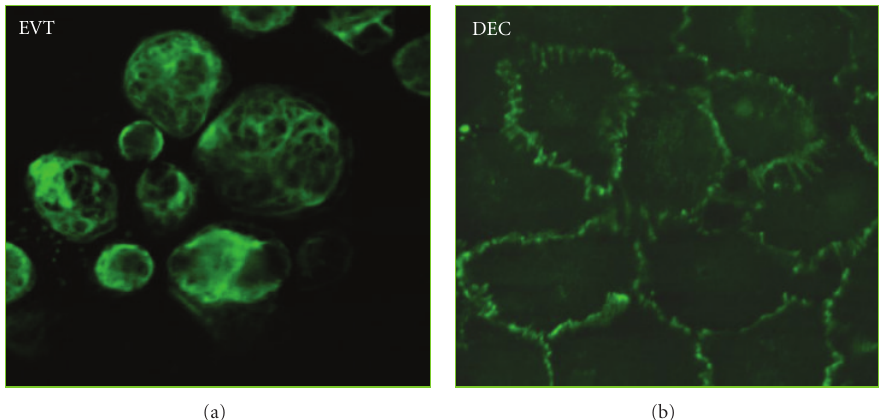
Figure 1: Immunofluorescence analysis of cells isolated from first trimester placenta. Purified EVTs were stained with mAb antihuman cytokeratin 7 (a) and DECs (b) with monoclonal anti-VE-cadherin. Images were acquired with Leica DM3000 microscope. Original magnification 100x.